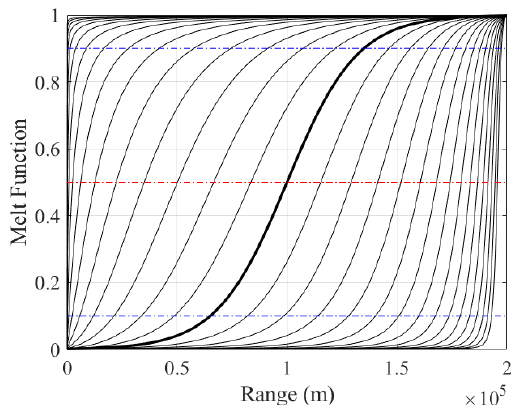
Figure 3. The curve of melt function m with melt parameter a in the range of − 1.5 – 1.5 (the interval of a is 0.1); The black thick line in the figure corresponds to the melt function when a = 0. The red dotted line is the transverse tangent when the melt function value m = 0.5. The blue dotted line is the transverse tangent when m = 0.1 and 0.9 respectively, and the corresponding abscissa distance is defined as the starting position and ending position of the frontal zone respectively. According to the starting position, ending position of the frontal zone (it can be obtained through FCM) and the function curve of melt function m with melt parameter a , we can identify the selection of the corresponding melt parameters.